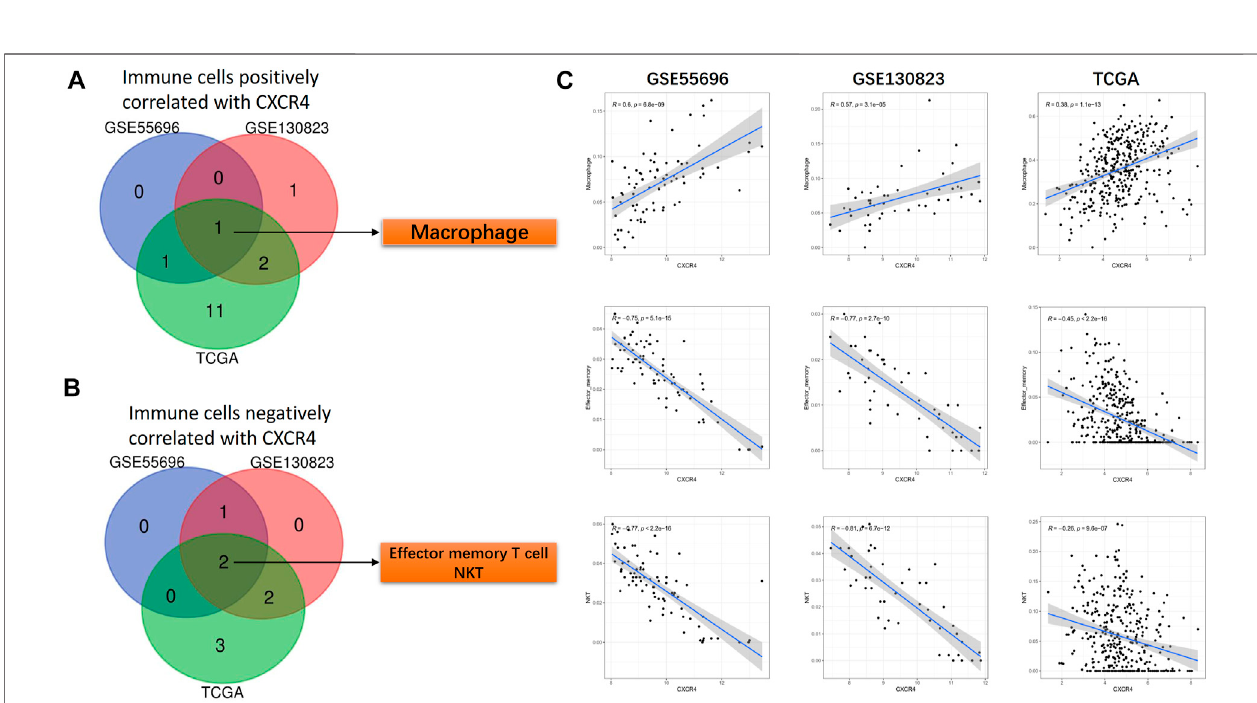
FIGURE 6 | CXCR4 co-expression immune cells. (A) Venn diagram showing macrophages positively correlated with CXCR4 expression in GSE55696, GSE130823, and TCGA cohorts. (B) Venn diagram showing effector memory T cells and NKT cells negatively correlated with CXCR4 expression in GSE55696, GSE130823, and TCGA cohorts. (C) Scatter plot showing the correlation between macrophages, effector memory T cells, and NKT cell abundance and CXCR4 expression levels in GSE55696, GSE130823, and TCGA cohorts.